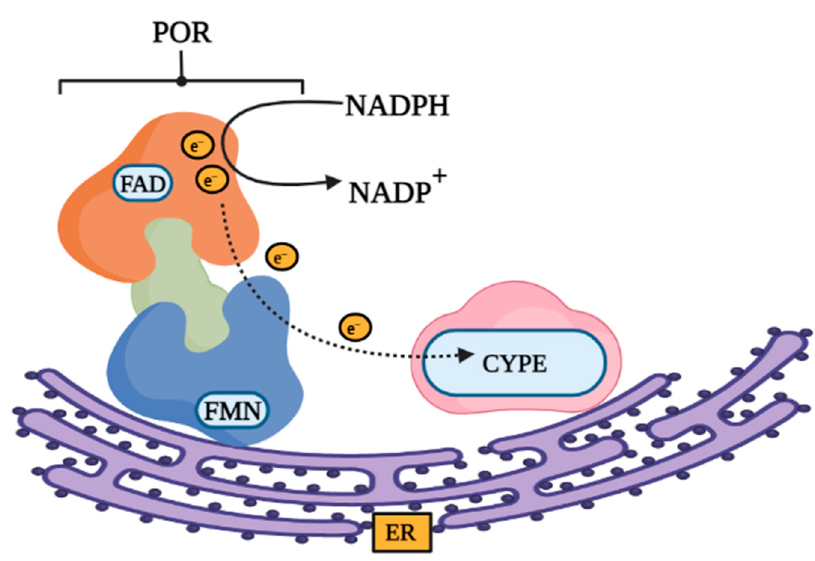
Figure 2. Structure of POR with its redox partner. POR consists of three protein domains which are the flavin adenine dinucleotide (FAD) binding domain, the flavin adenine mononucleotide (FMN) binding domain, and the NADPH binding domain. FAD and FMN are closely connected together via a flexible hinge region that changes shape to help bring FAD towards FMN allowing the electron transfer to take